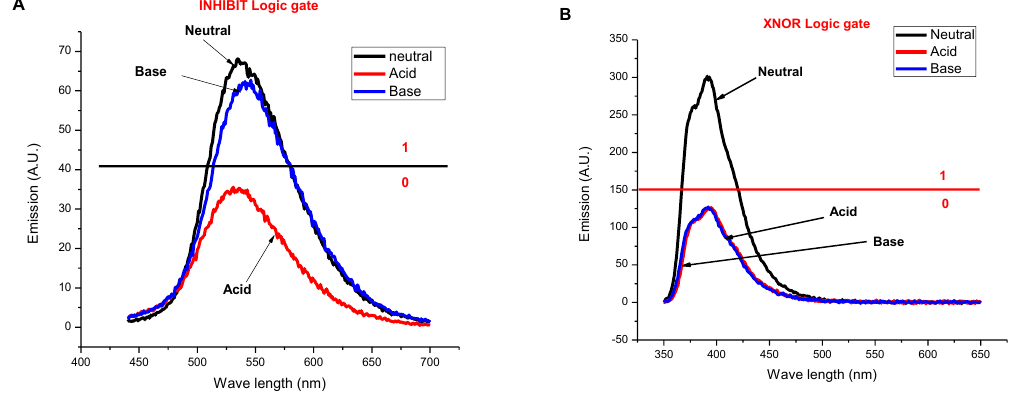
Figure 2. The changes in the fluorescence emission at 535 nm of probe NI2 ( A ) and the fluorescence